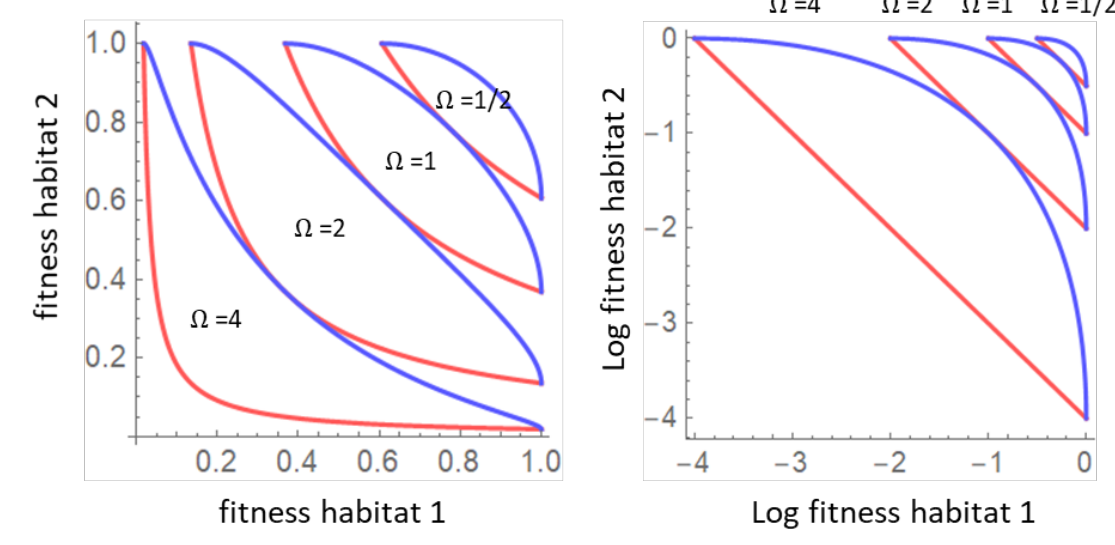
Figure 2 - Fitness trade-off curves between environments, for different intensity of stabilizing selection ( 𝛺 ). Without loss of generality, the difference in optimal phenotype between habitats is set to 1. Red: Laplace fitness function ( 𝛾 = 1 ). Blue: Gauss fitness function ( 𝛾 = 2 ). Left panel: fitness. Right panel: log